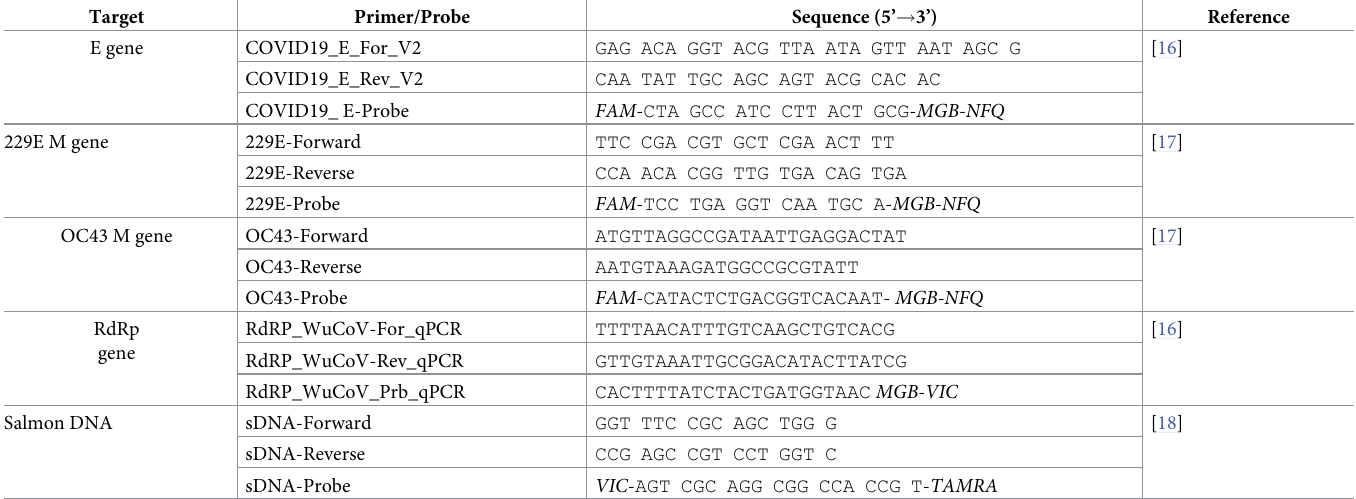
Table 1. Primers and probes for